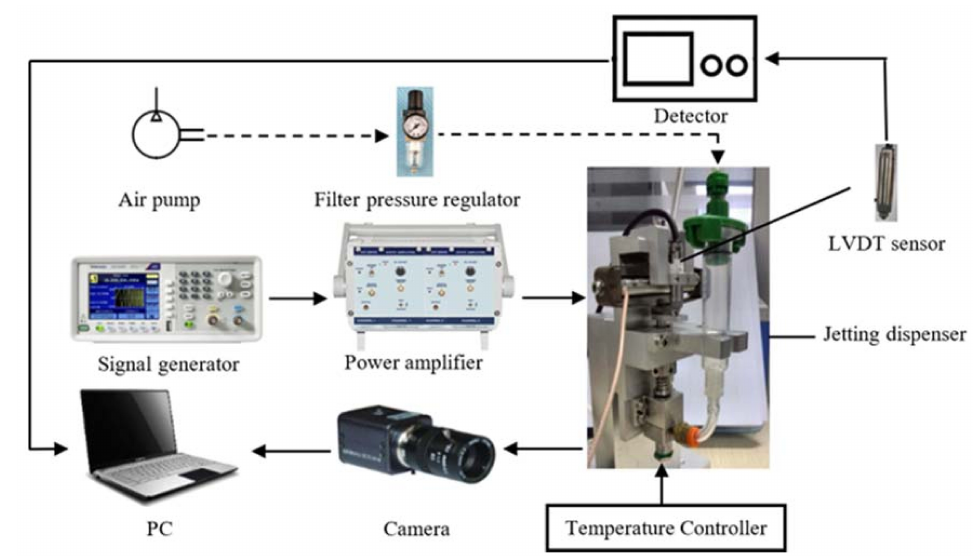
Figure 12. The schematic of the jetting experimental system.